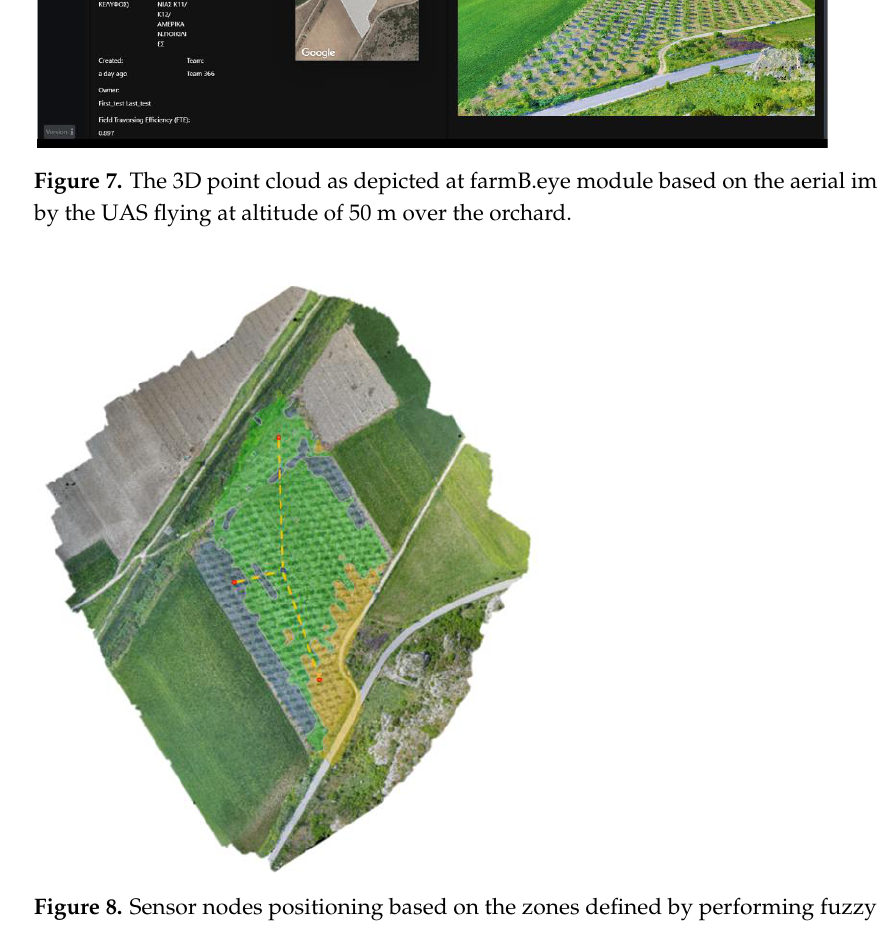
Figure 8. Sensor nodes positioning based on the zones defined by performing fuzzy clustering on the soil ECa, surface elevation data, and the field’s topology